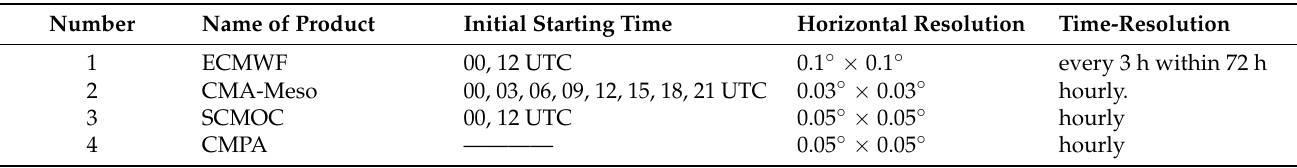
Table 2. Details of numerical model forecasts and CMPA